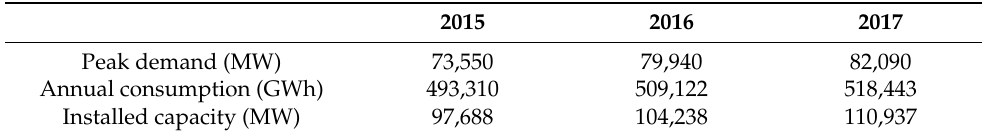
Table 1. Summary of the test system.